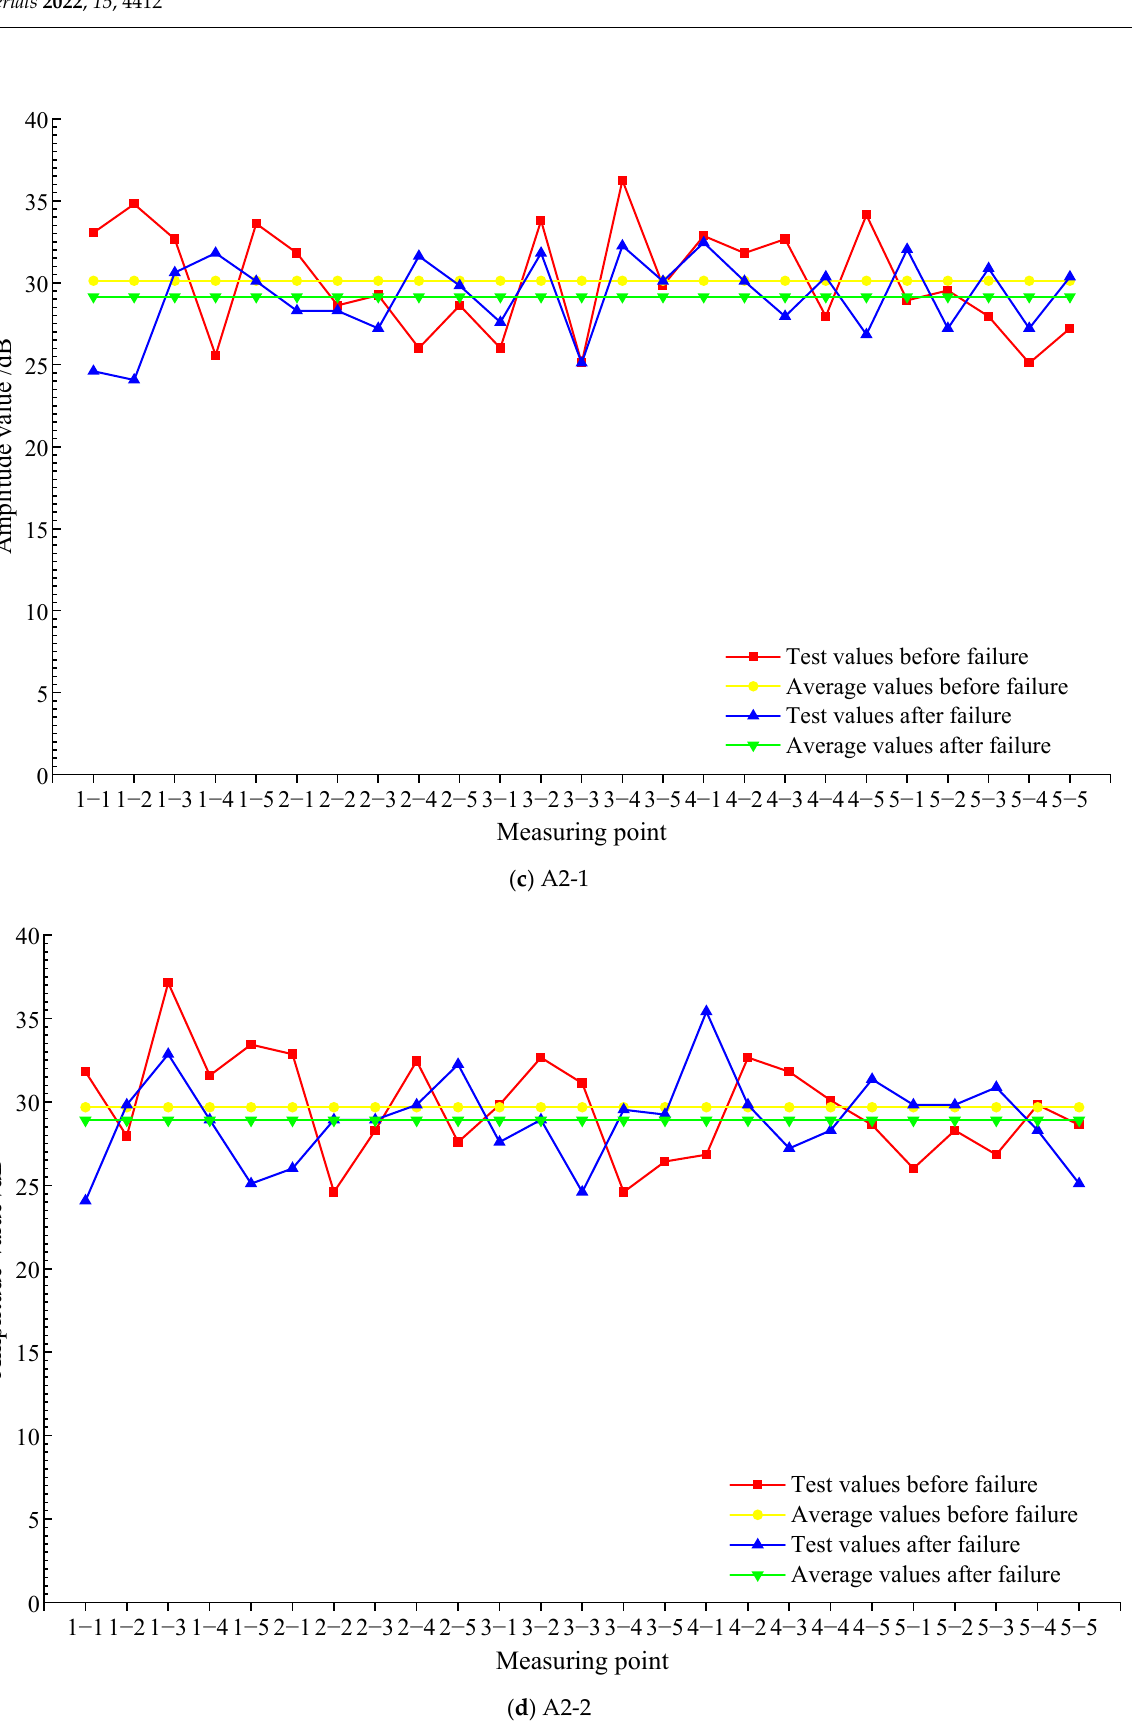
Figure 9. The amplitude value before and after the failure of each test